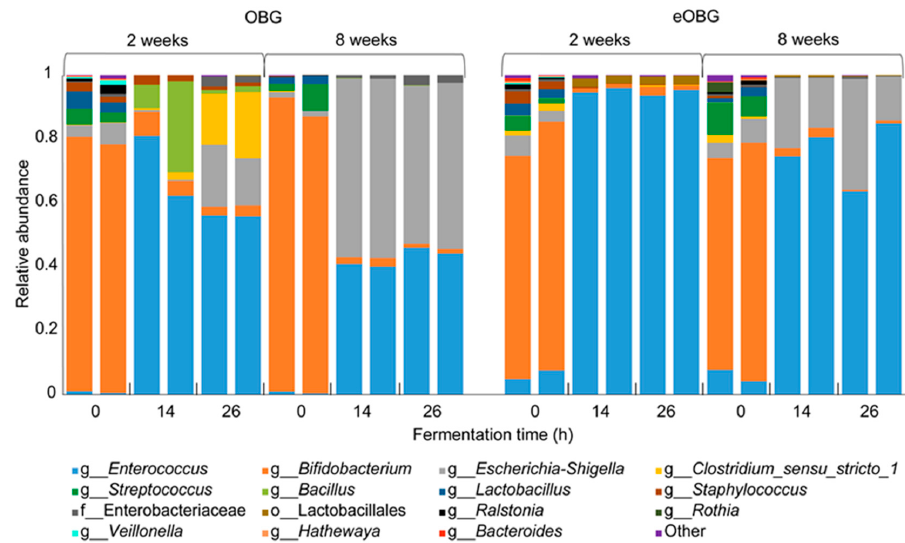
Figure 3. Relative abundance of bacteria at the highest classified taxonomy in duplicate fermentation digesta collected at the start and after 14 and 26 h from in vitro fermentation of media supplemented with native oat β‐ glucan (OBG) and enzyme ‐ treated oat β‐ glucan (eOBG) using pooled fecal inoculum of 2 ‐ and 8 ‐ week ‐ old infants.